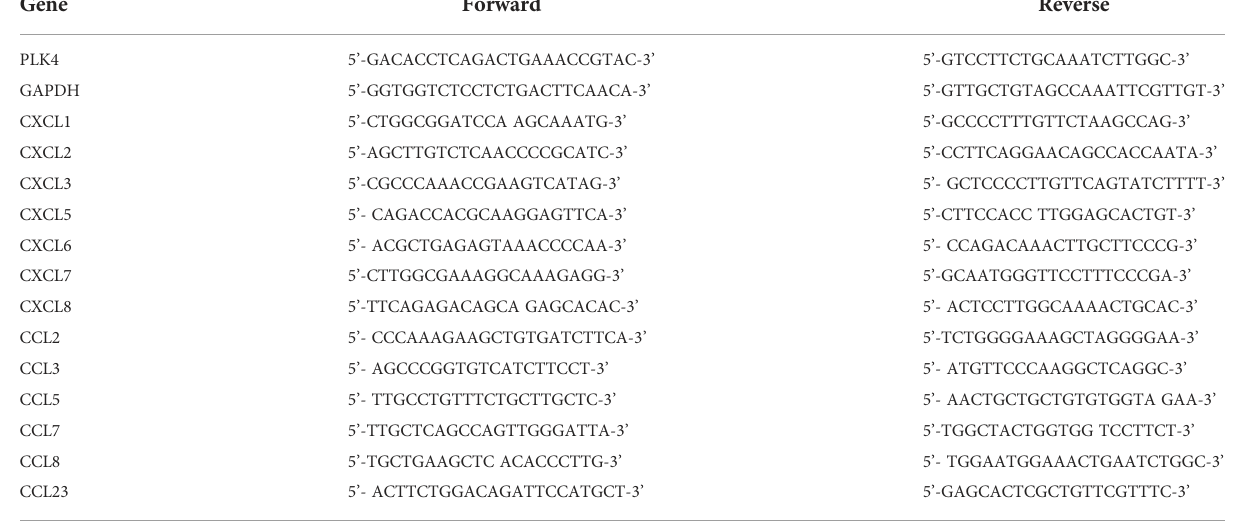
TABLE 1 Primers sequence used in the